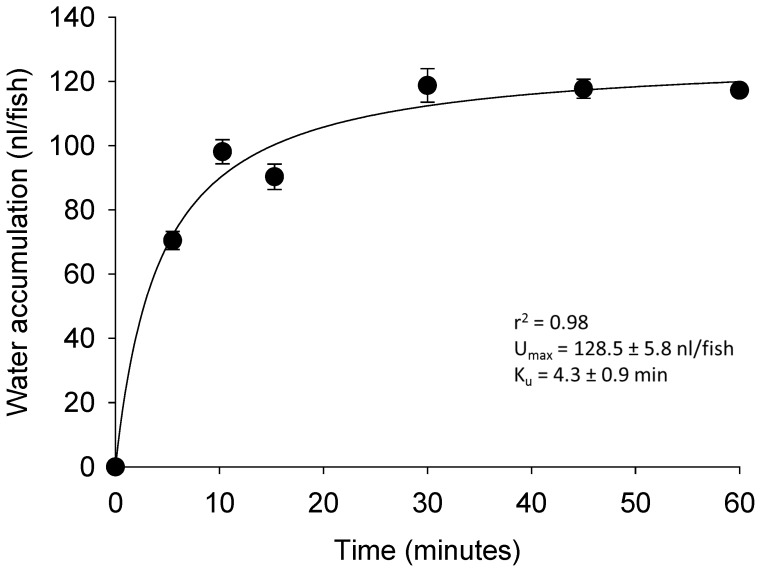
Characterization of water influx kinetics in larval zebrafish.The time-dependent accumulation of water in larval zebrafish at 4 dpf. The data were plotted using a hyperbolic equation: Jin  =  (Umax x t)/(Ku + t); Umax, maximum accumulation of water; t, exposure time (min); Ku, half-time for saturation of water. Values are means ± SEM (n = 6).